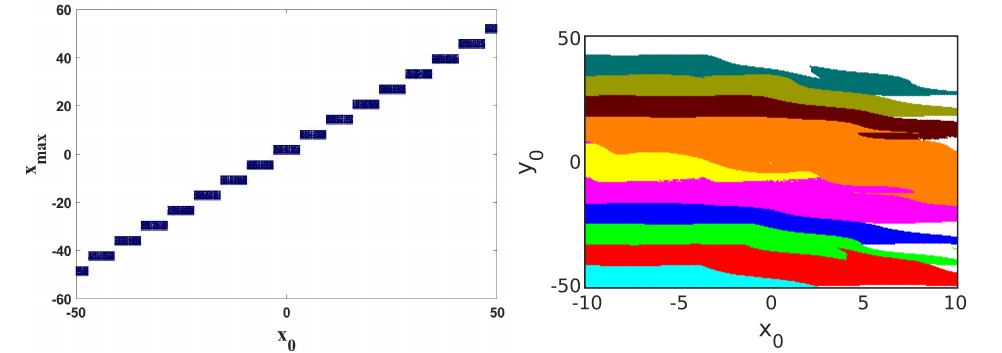
Figure 5. The bifurcation of different attractors as a function of initial state x 0 (left plot). Basin of attraction by varying the initial state of ( x 0 , y 0 ) for q = 0.98 (right plot). The distinct colors represent the basins for different